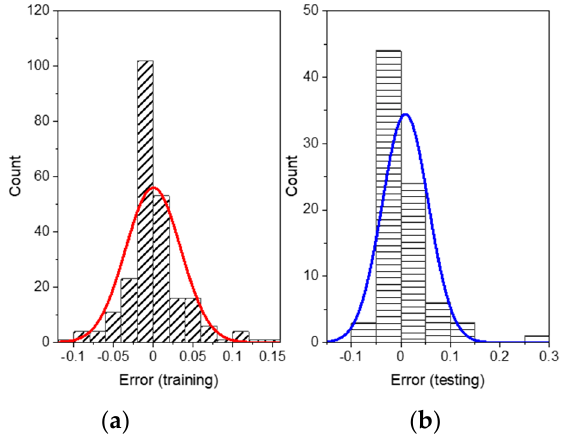
Figure 7. Error distribution for the ( a ) training and ( b ) testing data sets. The developed model was used to forecast rainfalls over the period from 2011 to 2020 and the outcomes were compared with the actual data as shown in Figure 8. The computed data appear to be in good agreement with the actual ones.